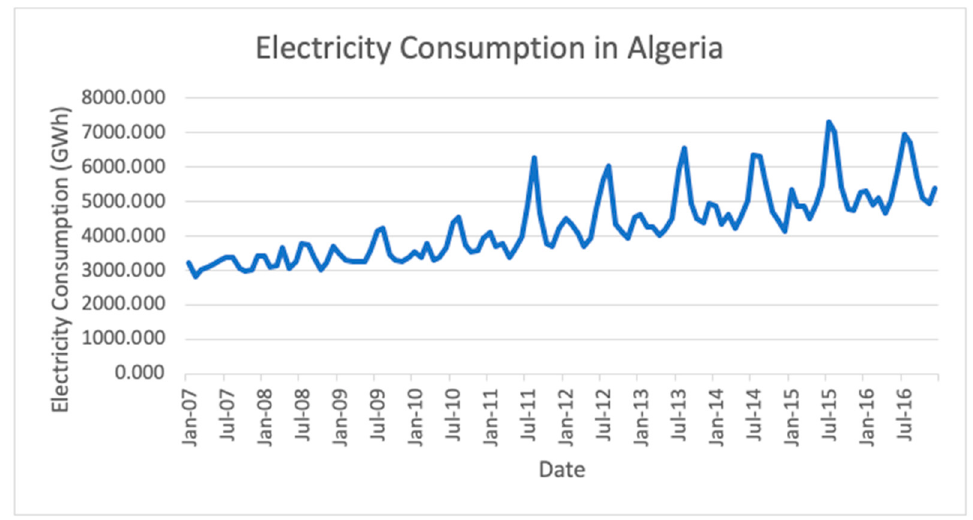
Figure 9. Electricity consumption in Algeria from 2007 to 2016.